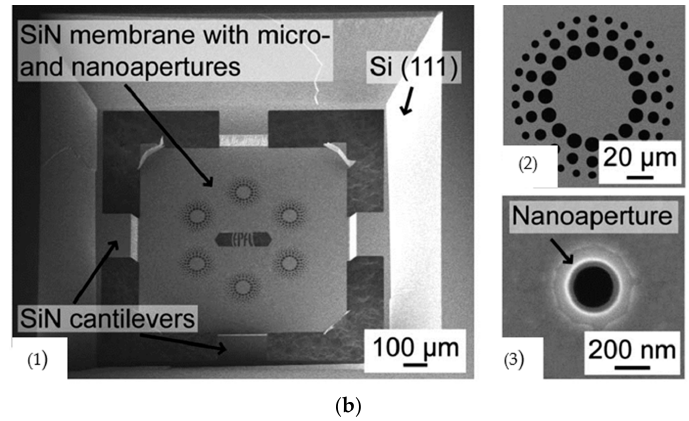
Figure 6. ( a ) Feature size of d Ʈ with a gap distance of g (left). Feature size of d Ʈ with a gap distance of g by using a compliant stencil mask. Reproduced from [68] with permission of The Royal Society of Chemistry. ( b ) SEM image of a free-standing compliant membrane suspended by four cantilevers (1) and the images of nanoapertures on the SiN x membrane (2,3). Reproduced from [68] with permission of The Royal Society of Chemistry.